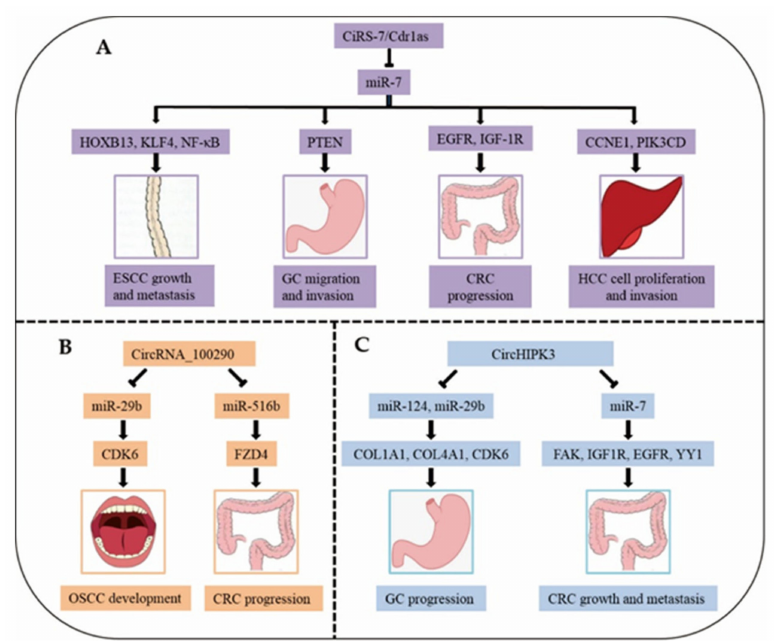
Figure 3. The mechanisms of three circRNAs (CiRS-7 / Cdr1as, CircRNA_100290 and CircHIPK3) in di ff erent diseases. ( A ), Mechanism of ciRS-7 in ESCC, GC, CRC, and HCC. ( B ), Mechanism of circRNA_100290 in OSCC and CRC. ( C ), Mechanism of circHIPK3 in GC and